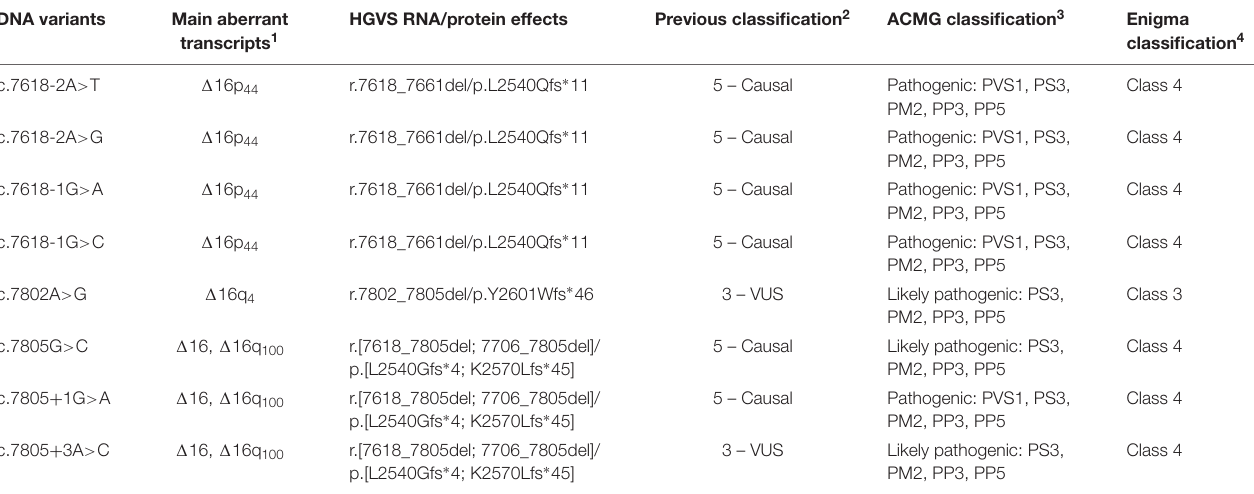
TABLE 4 | Classification of variants according to the ENIGMA and ACMG